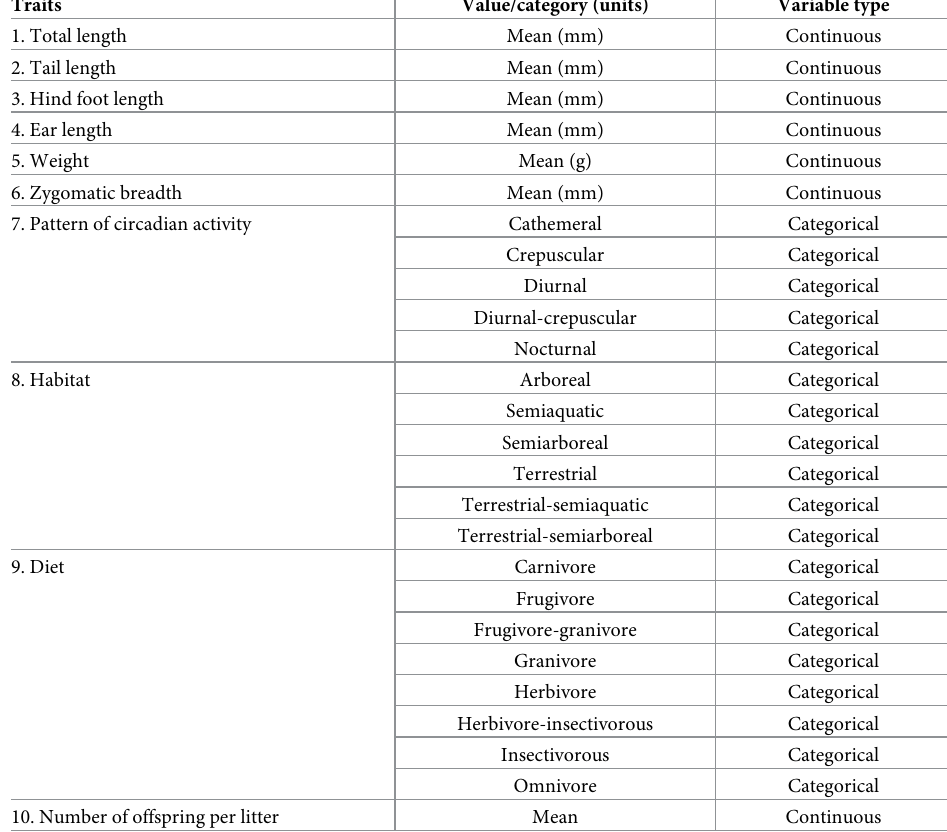
Table 1. Traits used to quantify the functional diversity of cricetid rodents of Oaxaca, Mexico. Traits Value/category (units) Variable